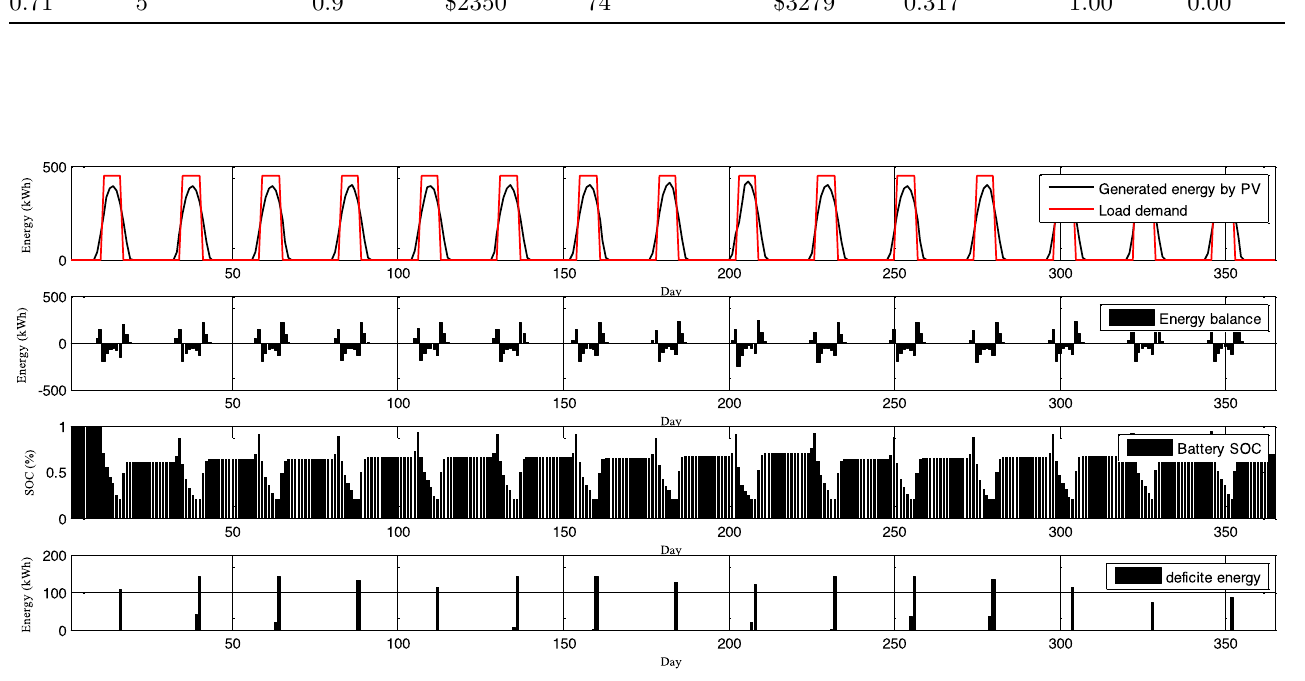
Fig. 5. System performance for complete